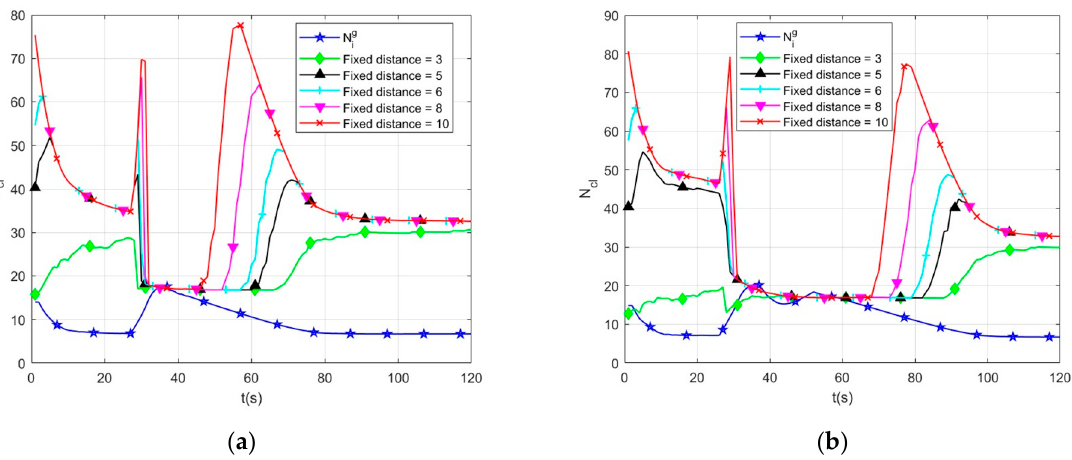
Figure 10. Variation of communication load under different interaction structures in two cases. ( a ) the communication load variation without back-capture; ( b ) the communication load variation with